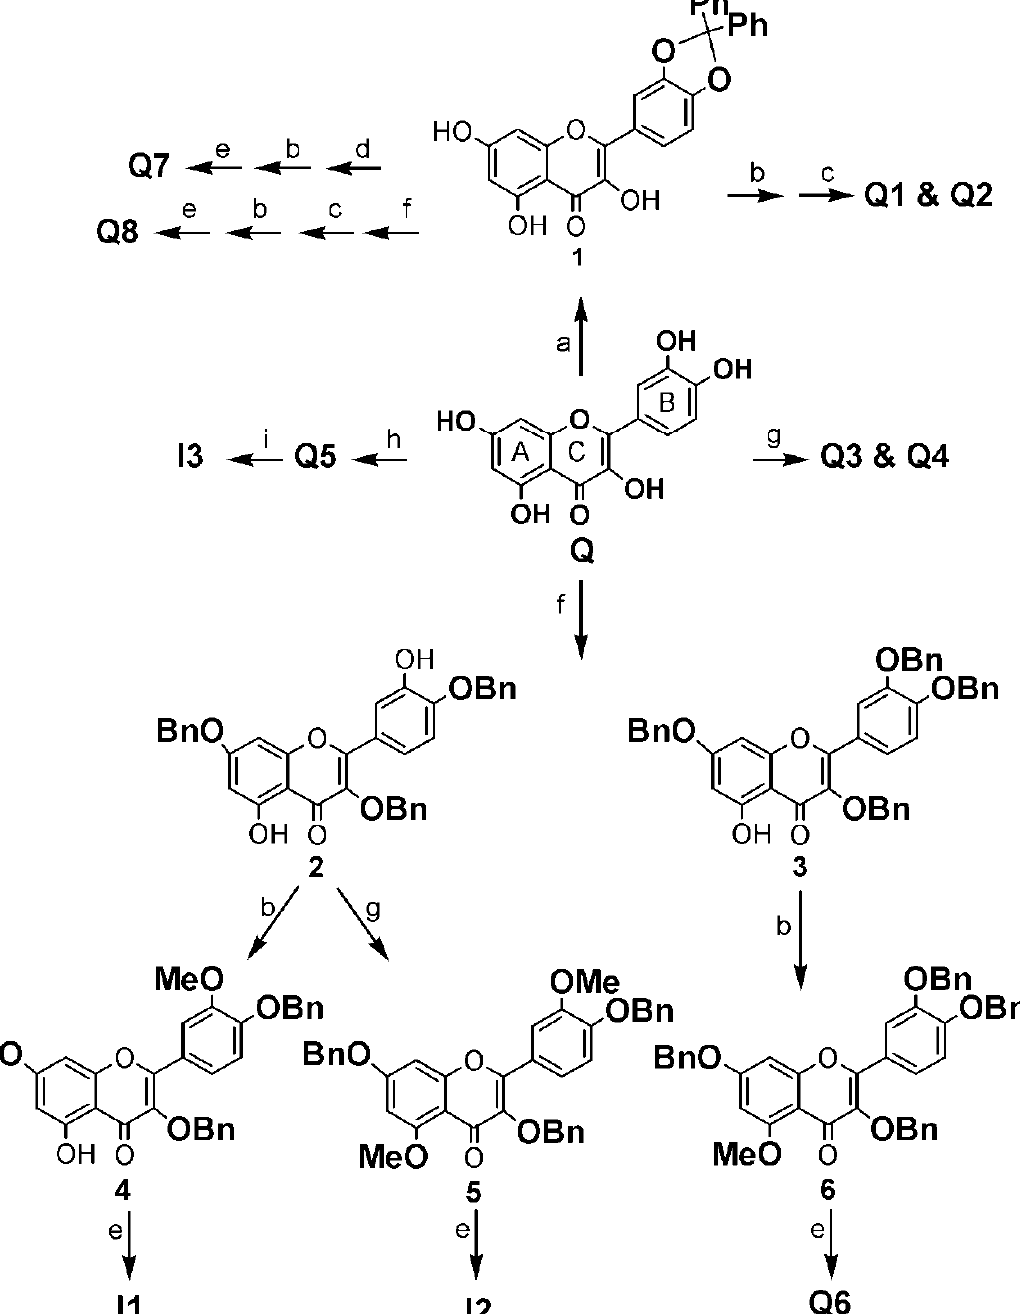
Scheme 1. Synthesis of the methylated derivatives of